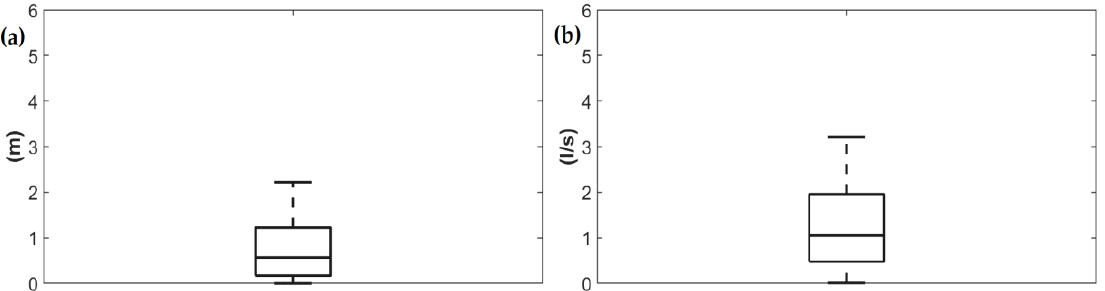
Figure 10. Absolute errors calculated as the absolute difference between reference values and simulated values in the final calibrated model of the Modena network. Panel ( a ) is related to the pressure at each node and panel ( b ) to the flow rate at each pipe.